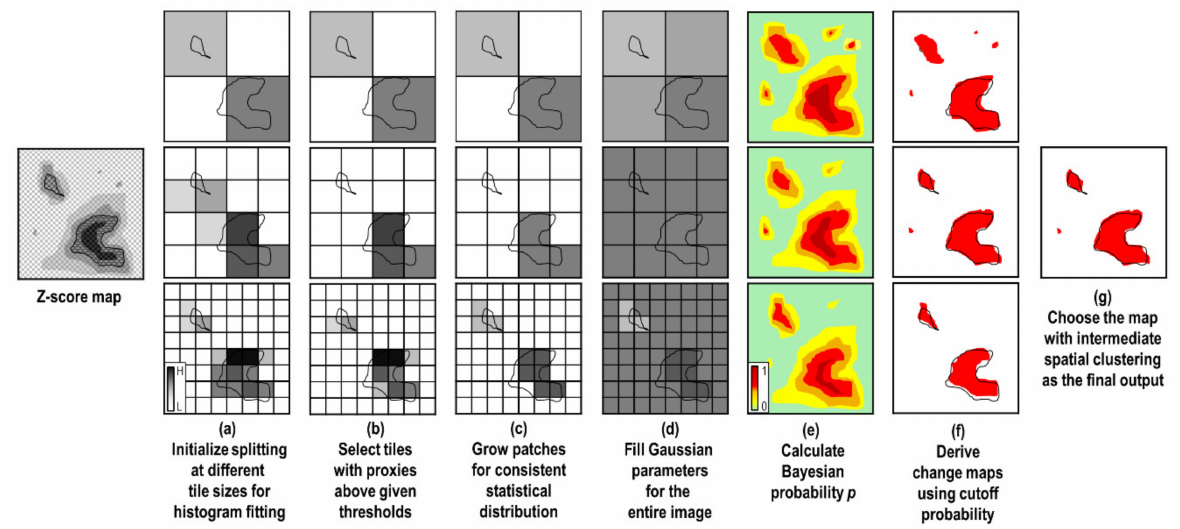
Figure 2. Growing Split-Based Approach (GSBA)